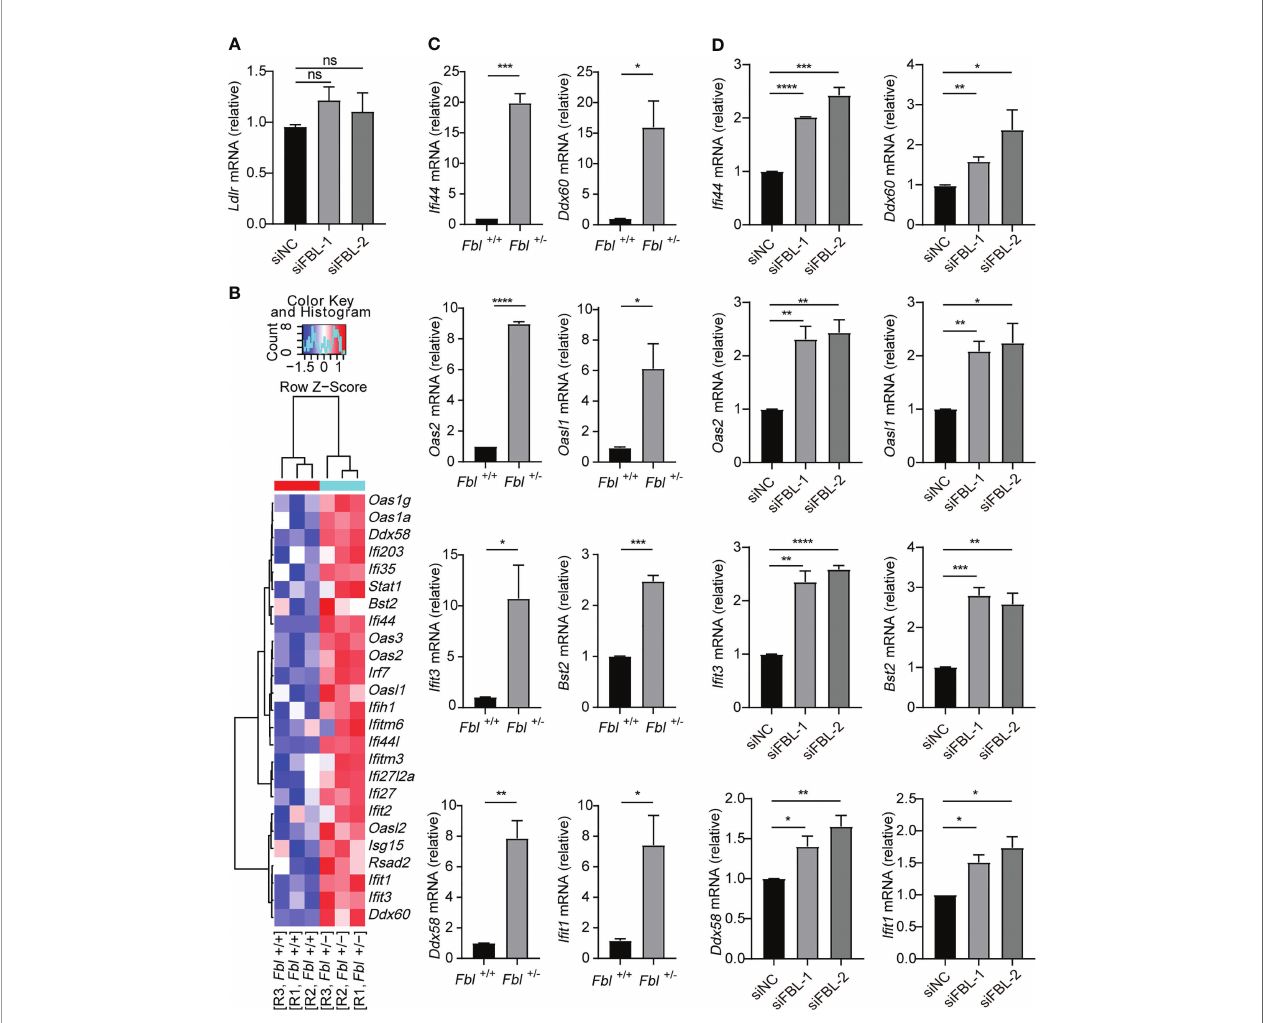
FIGURE 4 | FBL inhibits the expression of ISGs in macrophages. (A) qRT-PCR analysis of Ldlr mRNA in mouse peritoneal macrophages transfected with the indicated siRNAs for 48 h (n=3); (B) Hotmap showing normalized transcript expression levels of immune-associated genes in WT and Fbl +/- RAW264.7 cells (n=3); (C) qRT-PCR analysis of I fi 44 , Oas2 , I fi t3 , Ddx58 , Ddx60 , Oasl1 , Bst2 , I fi t1 mRNA in WT and Fbl +/- RAW264.7 cells (n=3); (D) qRT-PCR analysis of I fi 44 , Oas2 , I fi t3 , Ddx58 , Ddx60 , Oasl1 , Bst2 , I fi t1 mRNA in mouse peritoneal macrophages transfected with the indicated siRNAs for 48 h (n=3). Data are mean ± SEM of biologically independent samples. ns, not signi fi cant, * P <0.05, ** P <0.01, *** P <0.001, **** P <0.0001, two-tailed unpaired Student ’ s t